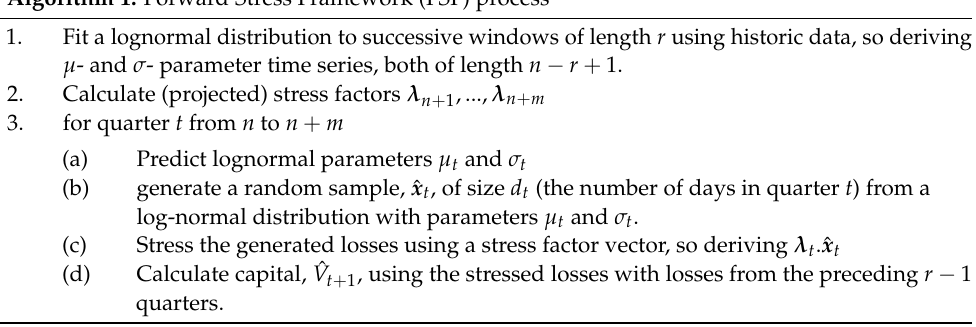
Algorithm 1: Forward Stress Framework (FSF)